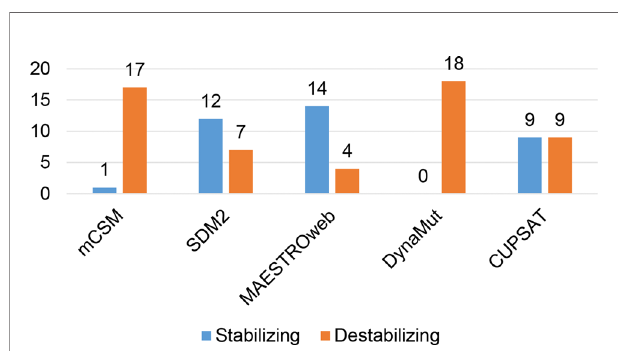
FIGURE 2 | Distribution of stabilizing and destabilizing mutations in SARS- CoV-2 Envelope protein predicted by structure-based tools.